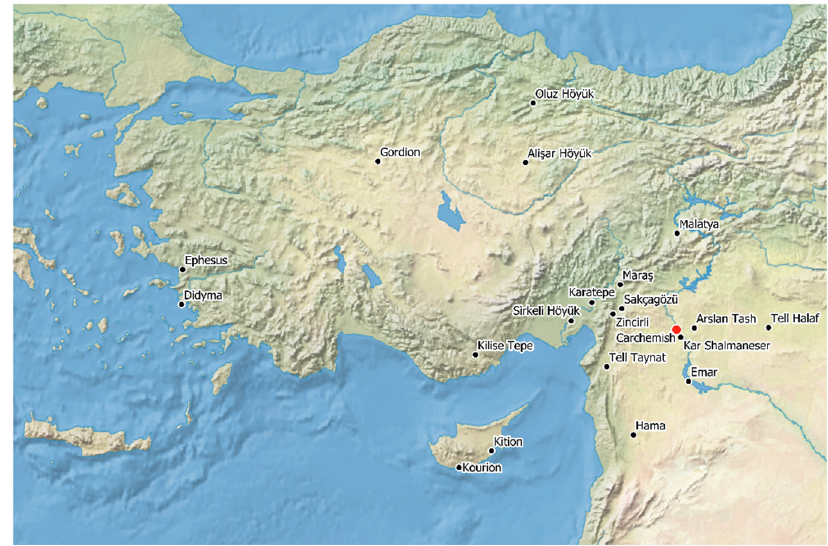
Figure 1. Location of sites mentioned in text (map by the author, geographical background from Natural Earth).